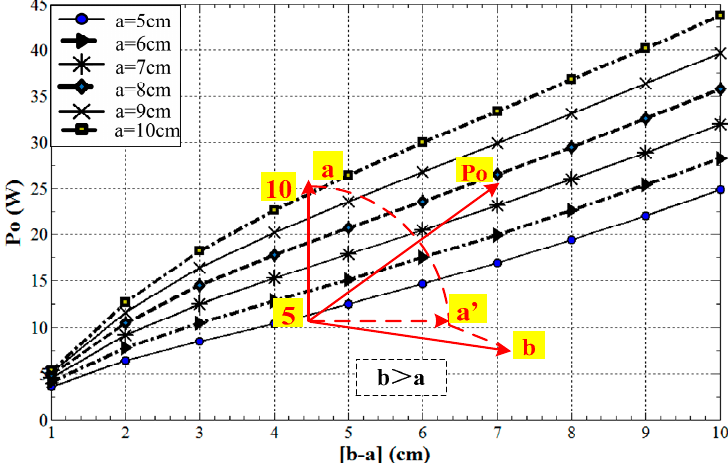
Figure 5. The relationship between the harvested energy and the inner/external diameter of the core. It is apparent from Figure 5 that output power increases as the radial thickness increases ( b ‐ a ).